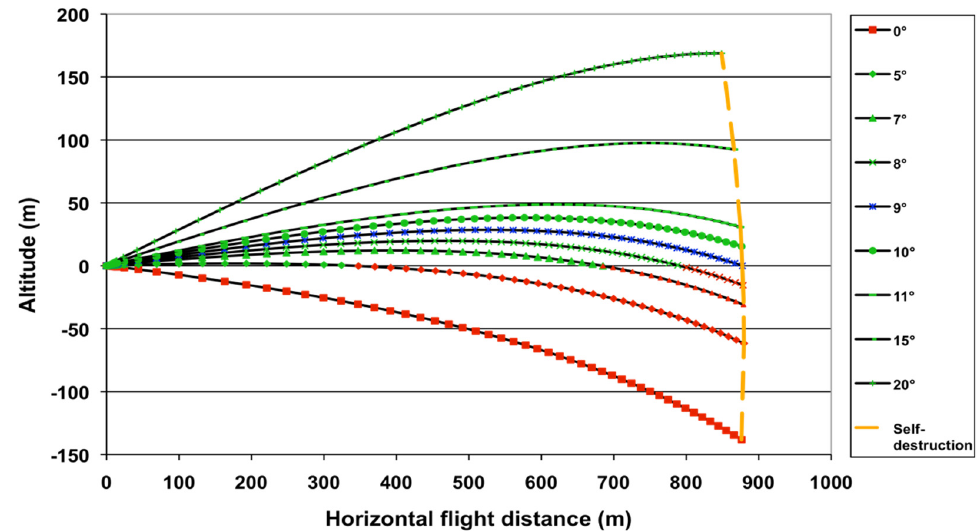
Figure 27. PG-7 projectile trajectory as a function of launch angle. Trajectory segments above the initial altitude of the weapon system are marked in green, trajectory segments below are marked in red. The trajectory corresponding to the maximum horizontal flight distance is marked in blue (9° launch angle). The maximum flight distance due to the 5 s delay of the self-destruction function is also indicated (orange line).